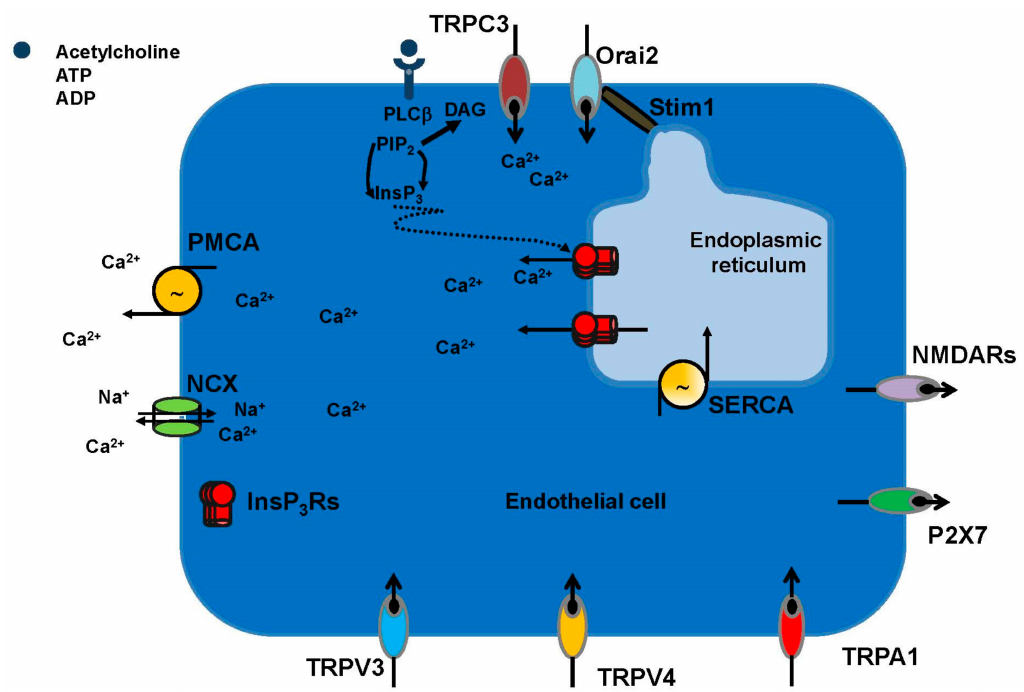
Figure 3. The Ca 2+ signaling toolkit in brain microvascular endothelial cells. There is scarce information available regarding the molecular components of the Ca 2+ signaling toolkit in brain microvascular endothelial cells. A recent investigation, however, provided a thorough characterization of the Ca 2+ machinery in bEND5 cells [76], which represent an established mouse brain microvascular endothelial cell line. Further information was obtained by the analysis of endothelial Ca 2+ signals in rodent parenchymal arterioles and in the human hCMEC/D3 cell line. Extracellular autacoids bind to specific G-protein-coupled receptors, such as M-AchRs and P2Y1 receptors, thereby activating PLC β , which in turn cleaves PIP 2 into InsP 3 and DAG. InsP 3 triggers ER-dependent Ca 2+ releasing by gating InsP 3 Rs, while DAG could activate TRPC3. The InsP 3 -dependent drop in ER Ca 2+ levels induces SOCE, which is mediated by the interaction between Stim1 and Orai2 in bEND5 cells. Moreover, extracellular Ca 2+ entry may occur through TRPV3, TRPV4 and TRPA1, which are coupled to either eNOS or EDH [77,78]. Finally, brain microvascular endothelial cells may express Ca 2+ -permeable ionotropic receptors, such as NMDARs and P2X7 receptors. The elevation in [Ca 2+ ] i decays to the baseline via the concerted interaction between SERCA and PMCA pumps, as well as through NCX [72,79,80]. Abbreviations: InsP 3 , inositol-1,4,5-trisphosphate; DAG, diacylglycerol; InsP 3 Rs, InsP 3 receptors; NCX, Na + –Ca 2+ exchanger; PMCA, plasma membrane Ca 2+ ATPase; PIP 2 , phosphatidylinositol-4,5-bisphosphate; PLC β , phospholipase C β ; SERCA, sarco-endoplasmic reticulum Ca 2+ -ATPase. The thicker line connecting PIP 2 to InsP 3 indicates a high amount of second messenger produced upon PLC β